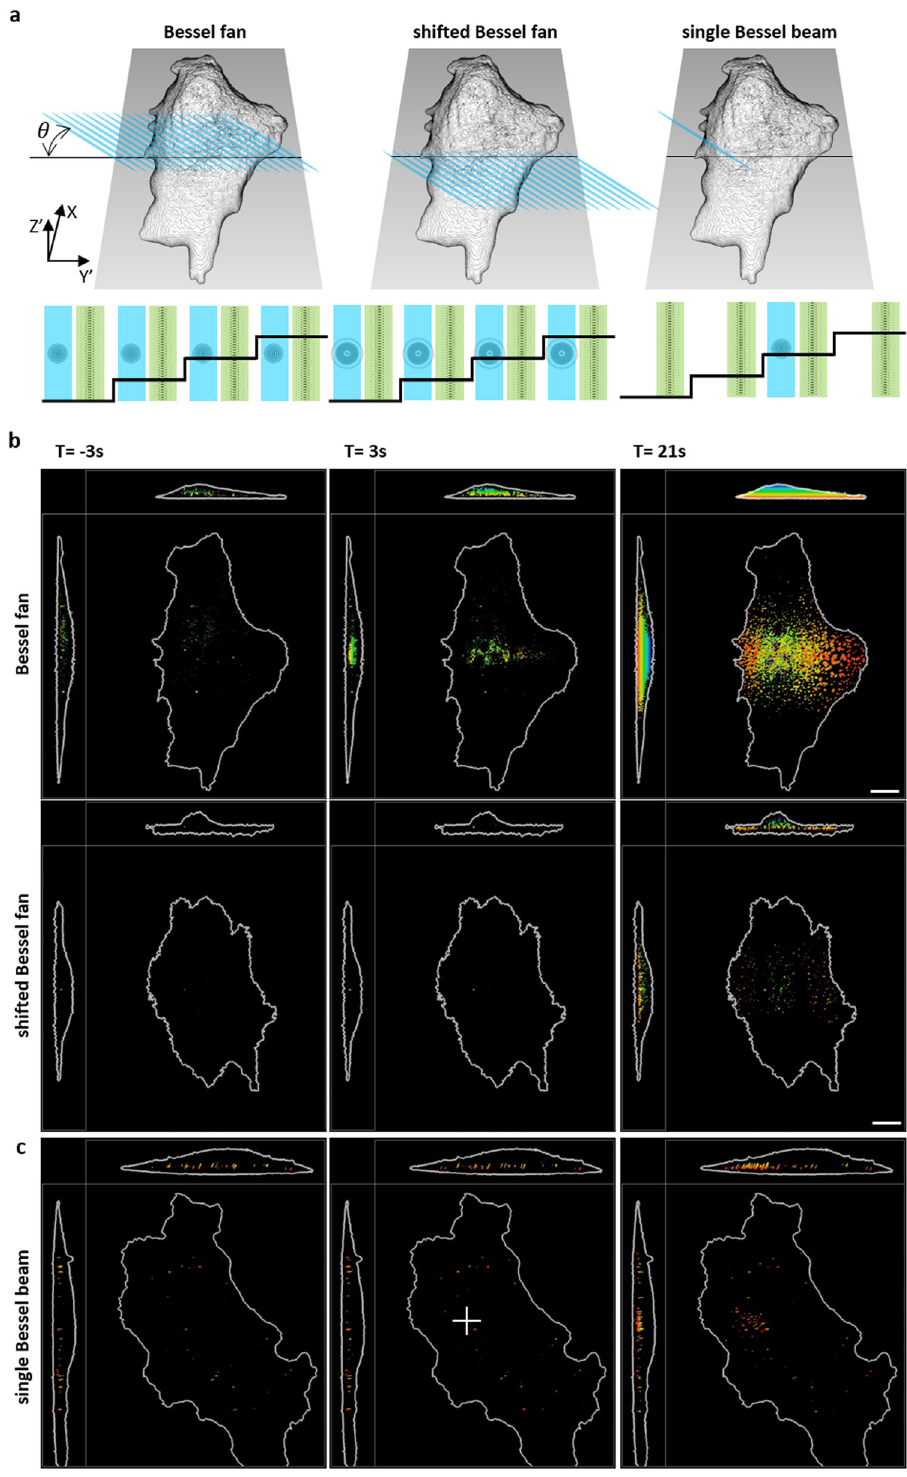
Fig. 2 3D image recordings of CRY2-olig proteins at different activation schemes. a The schematic for various activations: Bessel fan, shifted Bessel fan, and single Bessel beam. The activation beam illuminates on the Y ’ Z ’ plane at an angle of 32.8 0 . Bottom: The corresponding timing diagrams for the SLM patterns with laser 488 nm Bessel beam (blue) and 560 nm lattice beam (green) illumination synchronized with sample piezo waveforms (black). b The time-lapse images of optical induced clustering of CRY2olig-mRuby3 in XY ’ Y ’ Z ’ XZ ’ planes stimulated by Bessel fan and shifted Bessel fan activation. The depth of the oligomerization is color-coded, where the process of oligomerization occurs only at the basal membrane by the shifted Bessel beam activation. c The center part of the cell marked by the white cross is illuminated by the single Bessel beam. Oligomerization occurs near the activation site. Scale bar 10 μ